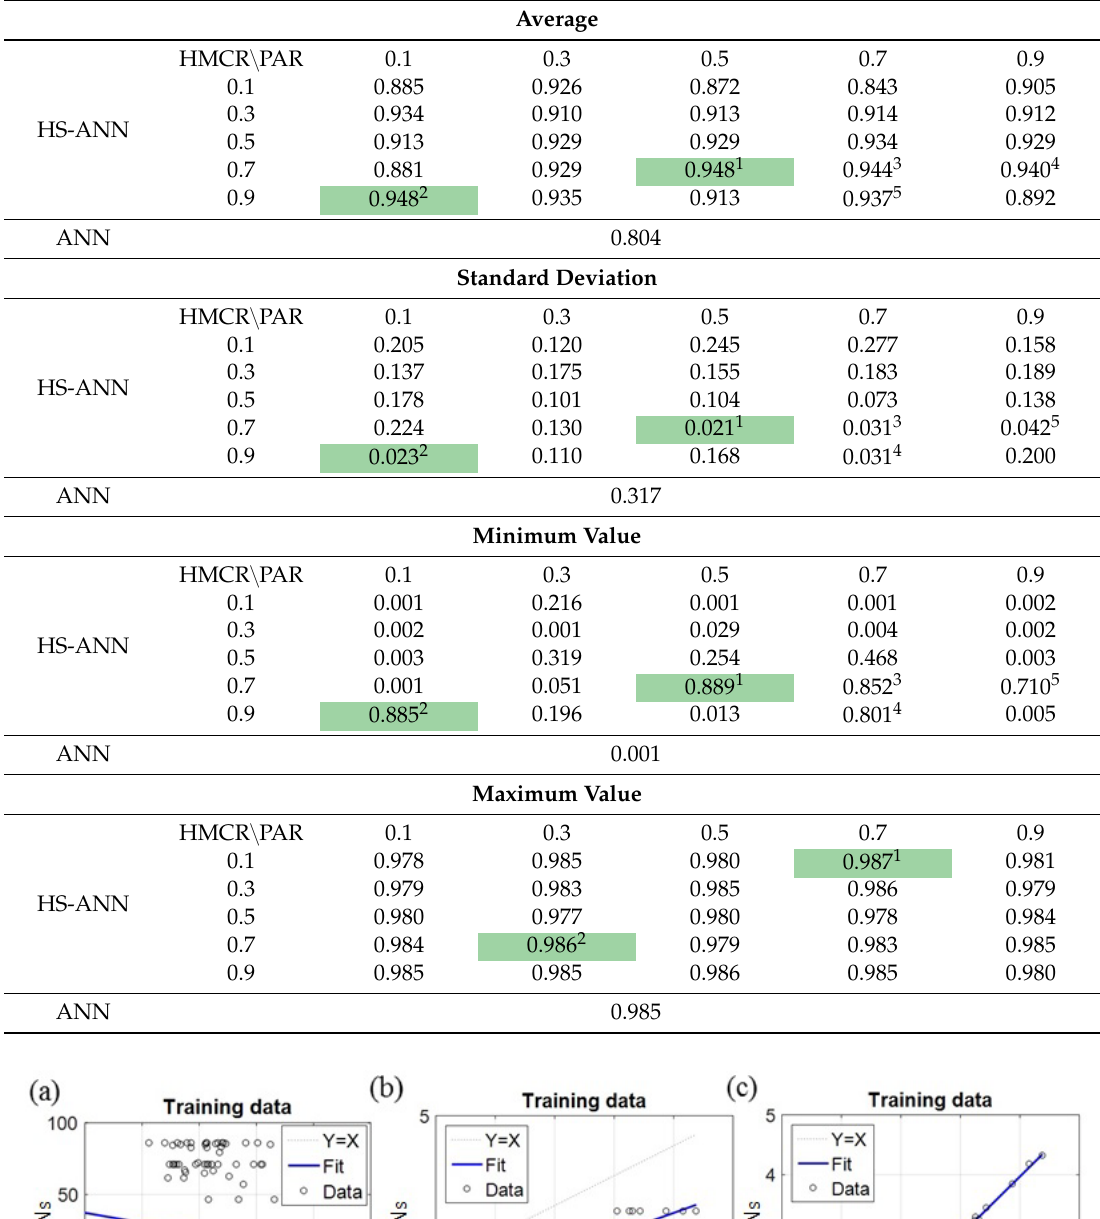
Table 5. Statistical parameters for index of agreement.